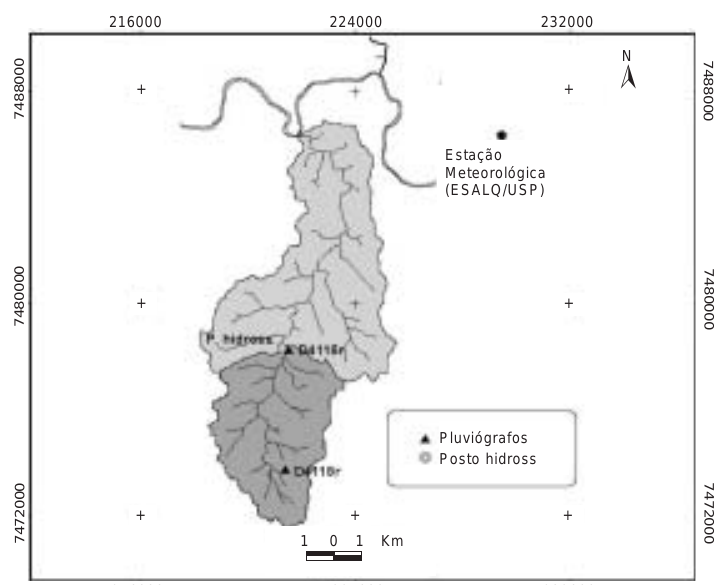
Figura 1. Microbacia do Ribeirão dos Marins, com localização do posto hidrossedimentométrico e dos